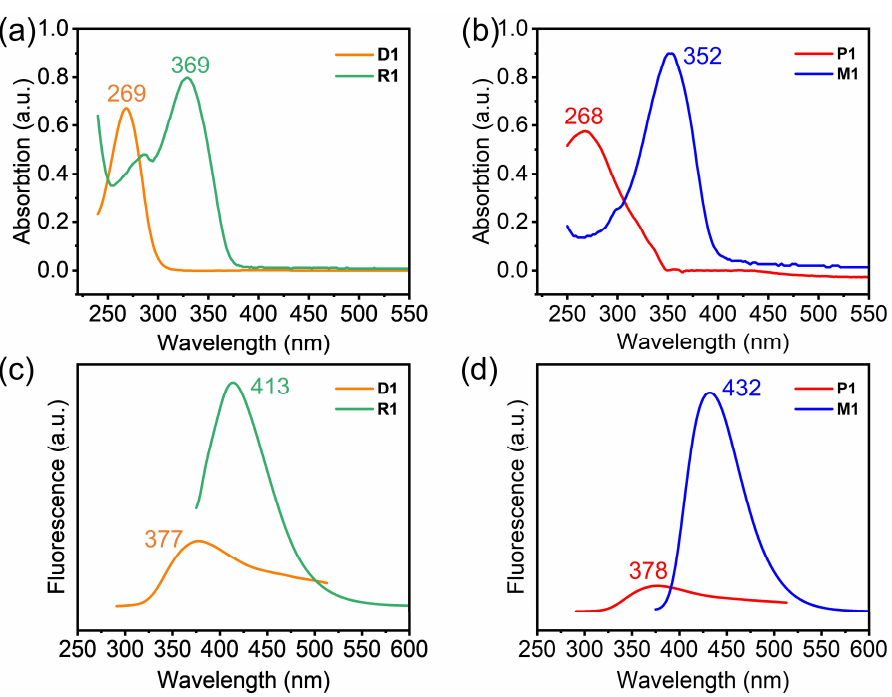
Figure 4. ( a , b ) are the UV-vis absorption spectra and ( c , d ) fluorescence spectra of D1 , R1 , P1 , and M1 Figure 4. ( a ) and ( b ) are the UV-vis absorption spectra and ( c ) and ( d ) fluorescence spectra of D1 , R1 , P1 , and M1 .